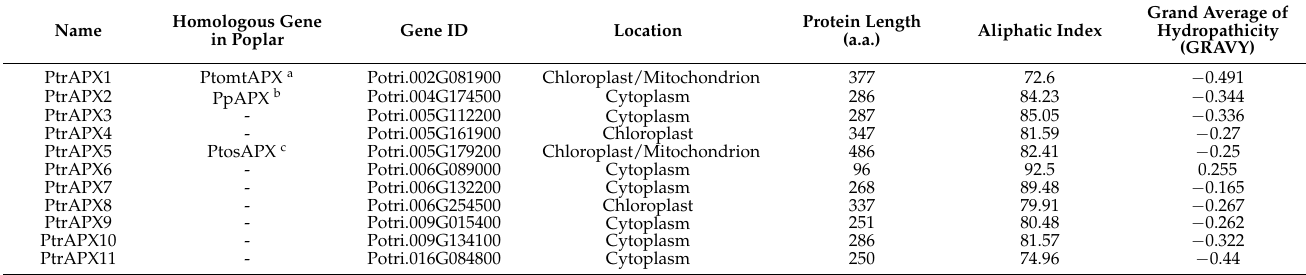
Table 1. Identifiers and physicochemical properties for the 11 APX gene family members in P. trichocarpa